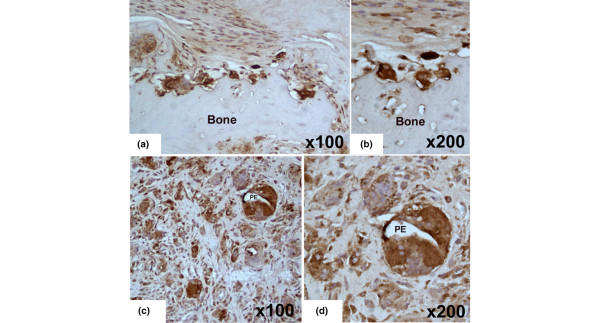
CD68 detection in sections of human peri-implant tissues using immunohistochemistry with rabbit polyclonal antibody. (a, b) CD68 is detected in the multinuclear and mononuclear cells located in the soft tissues and multinuclear cells on the bone surface. (c, d) CD68 is also detected in multinuclear and mononuclear cells associated with polyethylene (PE) particles.